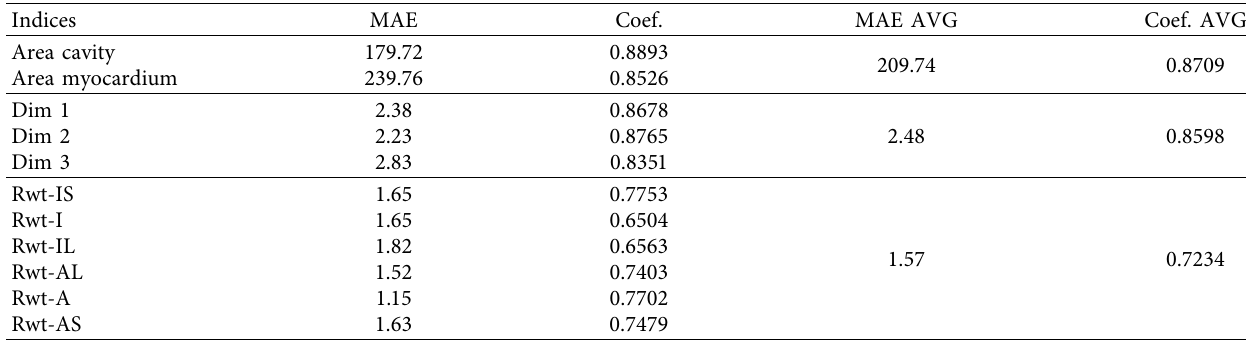
Figure 4: Decoder built in GRUs with attention. Encoder_Output is the output from the encoder which learns temporal features from the input cardiac frame sequences and Input_Step is one of the frames in the input cardiac frame sequence. Table 2: Performance evaluation of the proposed method.